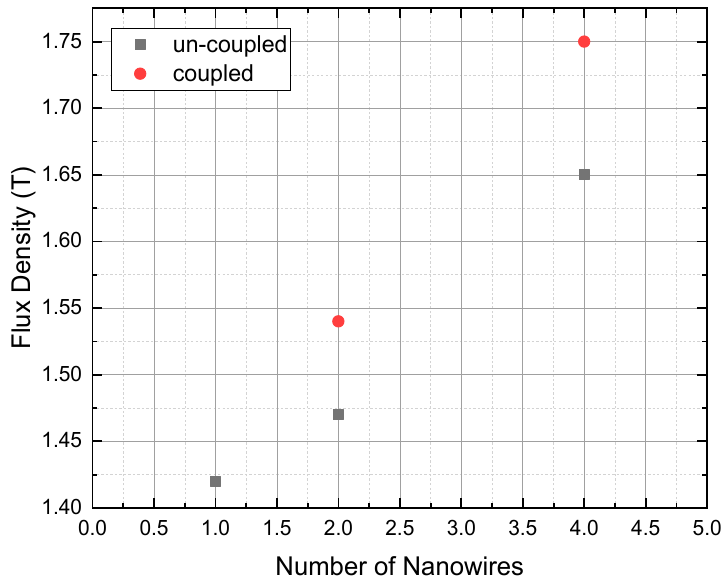
Figure 7. The computed values of flux density for 1, 2 and 4 GaN nanowires. The square blocks represent flux density for uncoupled nanowires and circles represent flux density for the coupled nanowires exhibiting the effects of coupling on flux density with increase in number of nanowires.